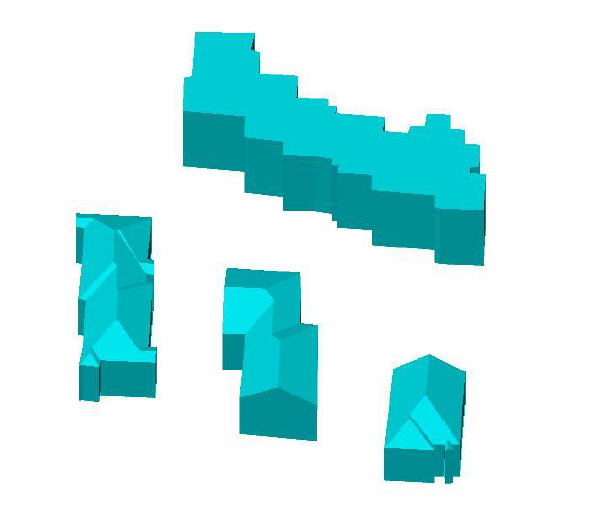
Figure 6-LoD2 3D CityGML model by ArcGIS